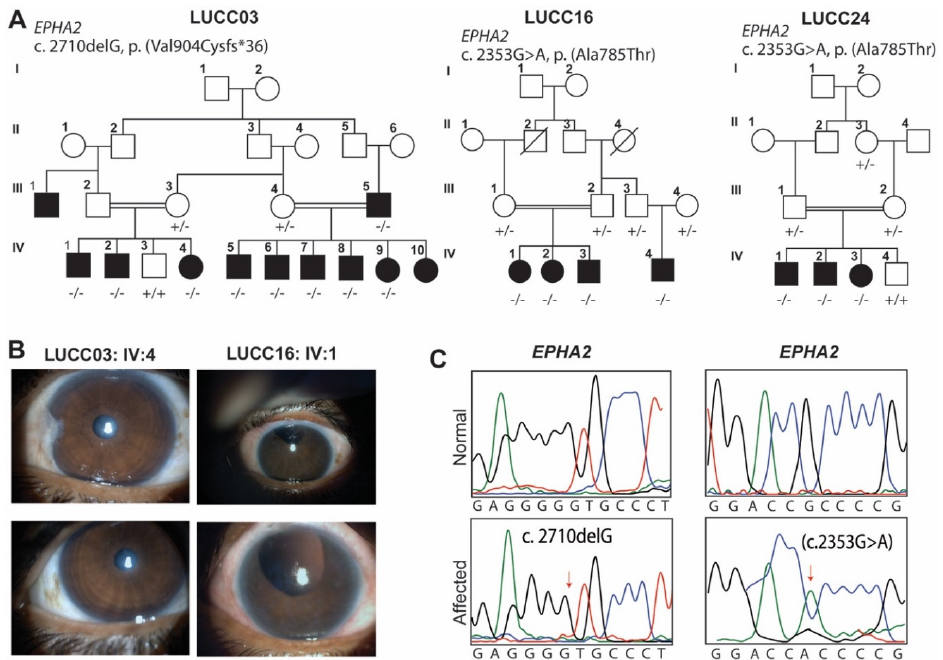
Figure 1. Cataract phenotype is associated with pathogenic variants of EPHA2 . ( A ) Pedigrees of families LUCC03, LUCC16 and LUCC24. Double lines indicate consanguineous families, empty symbols represent unaffected individuals, and filled symbols affected individuals. The genotypes of the identified variants are also shown for each of the participating family members. All three families had recessive mode of inheritance. ( B ) Images of Slit lamp examination the LUCC03 IV:4 revealed nuclear cataract developed congenitally, while LUCC16 IV:1 had aphakic eyes. ( C ) Sanger sequencing DNA chromatograms of EPHA2 variants found in this